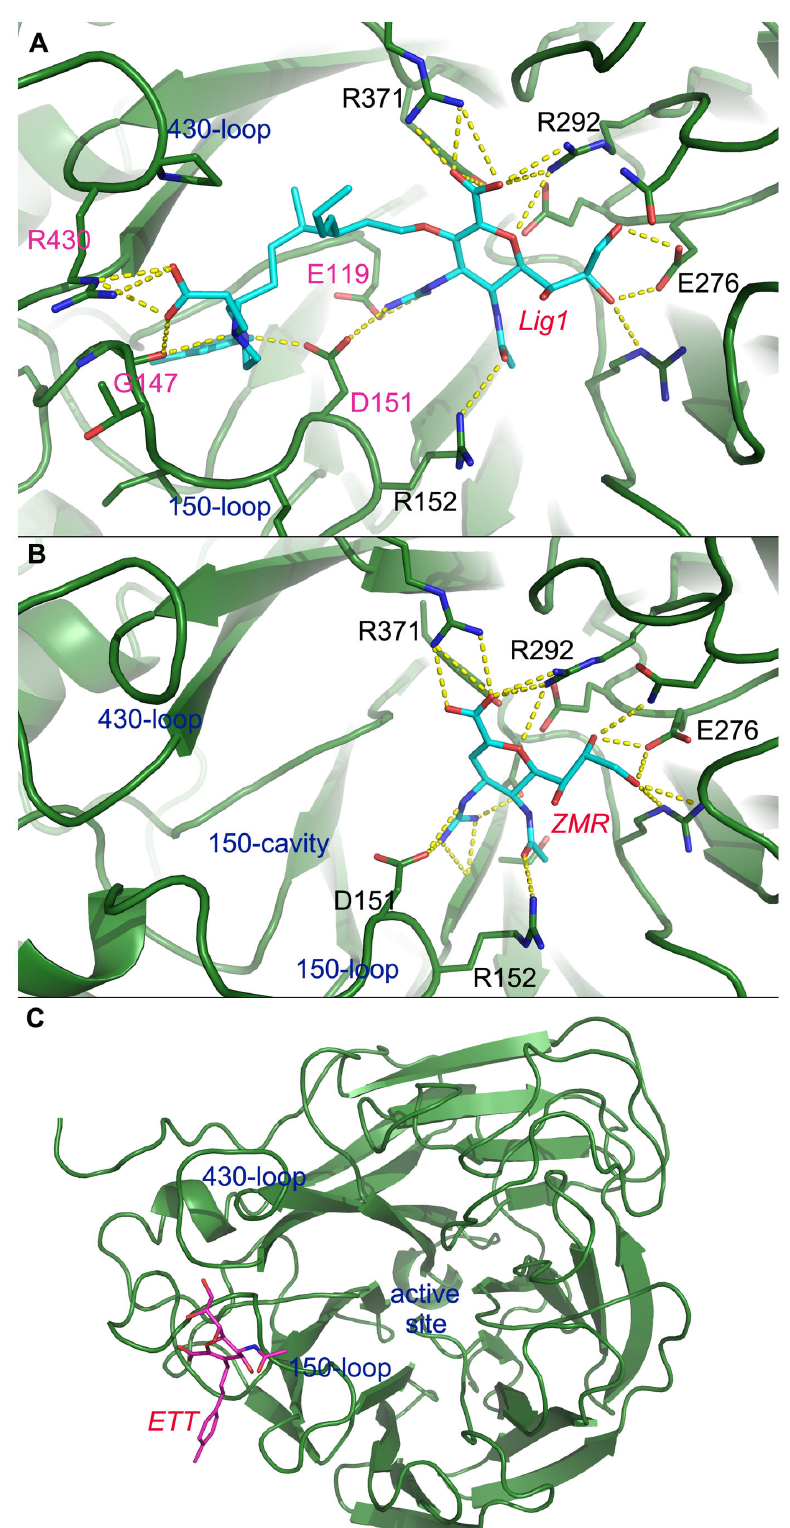
Figure 10. Final snapshot of the complex structure in different systems. Lig 1, ZMR and ETT bound with 09N1 at t=20 ns are shown in panels A, B and C, respectively. doi: 10.1371/journal.pone.0073344.g010 PLOS ONE |